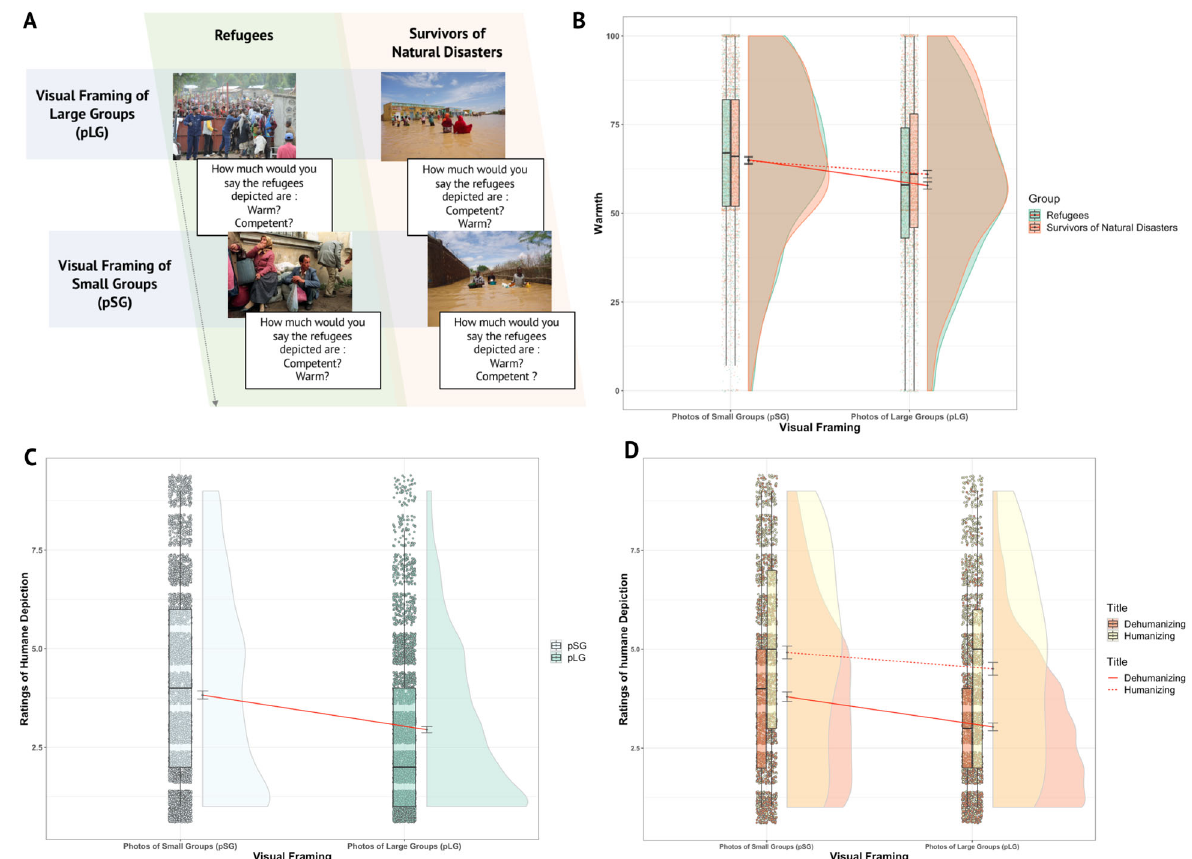
Fig. 2 Experimental design of study 3 and results of studies 3, 4 and 5. A 2 × 2 within-subjects design of Study 3. Visual framing was randomized within blocks, while block order (i.e. refugees or SNDs) was counterbalanced across participants. B Raincloud plot with fi tted values of the main effects of Visual framing on Attribution of Warmth in function of the Visual Framing and the Group (Ref vs. SND). Y -axis = Attribution of Warmth after exposure to photographic images of Ref (refugees, in green) and SND (Survivors of Natural Disaster in red). Dots represent single data points; boxplots and half violin plots represent the mean and probability distribution according to condition. Red line, black points and error-bars (SEM) represent fi tted values of the main effect of Visual Framing on Attribution of Warmth in function of the Group (Refugees vs. SND). After exposure to pLG of refugees (green and straight red line), participants assigned signi fi cantly ( p < 0.01) less warmth than after exposure to pSG, as well as in comparison to SND (red and dotted red line). C Study 4: Explicit ratings ( fi tted values) of humanness of photographic images across the two Framings. Dots represent single data points; boxplots and half violin plots represent the mean and probability distribution according to condition. Red line, black points and error-bars (SEM) represent fi tted values of the main effect of Visual Framing on Ratings of Humanness. Participants rated pLG of refugees as signi fi cantly ( p < 0.001) less humane than pSG. D Study 5: Explicit ratings ( fi tted values) of front-covers ’ (headlines and images) humanness as a function of Visual Framing (pSG/pLG) and Headlines (Humanizing/Dehumanizing) characteristics. Dots represent single data points, boxplots and half violin plots according to condition pSG/pLG. Red line, black points and error-bars (SEM) represent fi tted values. Humanizing Headlines and pSG independently predicted high humanness ratings. The interaction was also signi fi cant ( p < 0.001), i.e. the combination of pLG with dehumanizing headlines predicted particularly low ratings, and the combination of pSG with humanizing headlines was associated with higher perceptions of humaneness (as re fl ected by the different slopes in the solid and dashed red